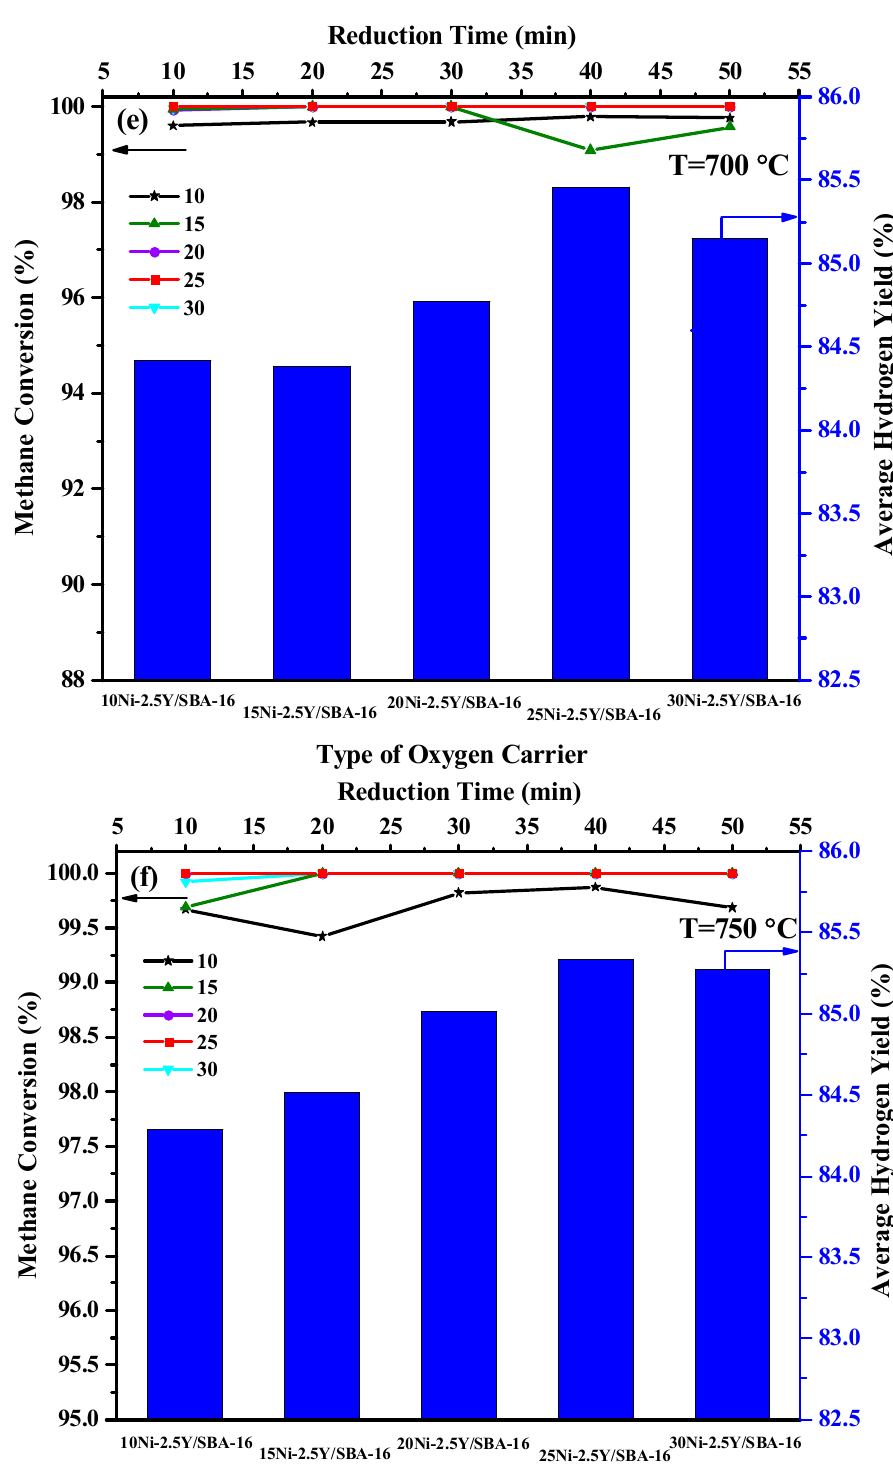
Figure 9. The effect of Ni weight percentage on the methane conversion and average hydrogen yield of xNi ‐ 2.5Y/SBA ‐ 16 oxygen carriers at reduction temperature of ( a ) 500 °C; ( b ) 550 °C; ( c ) 600 °C; ( d ) 650 °C; ( e ) 700 °C and ( f ) 750 °C.